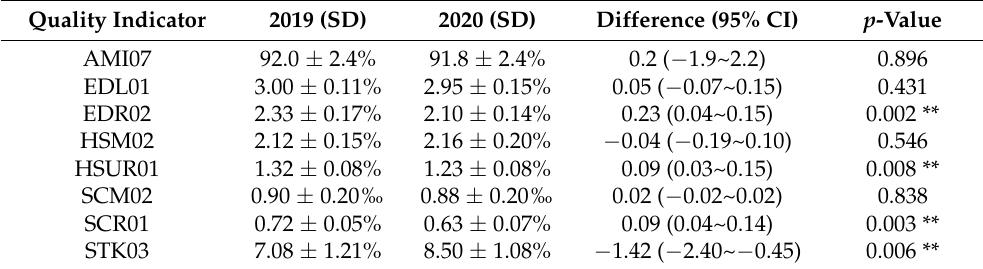
Table 2. Comparison of different indicators before and during the outbreak of COVID-19.